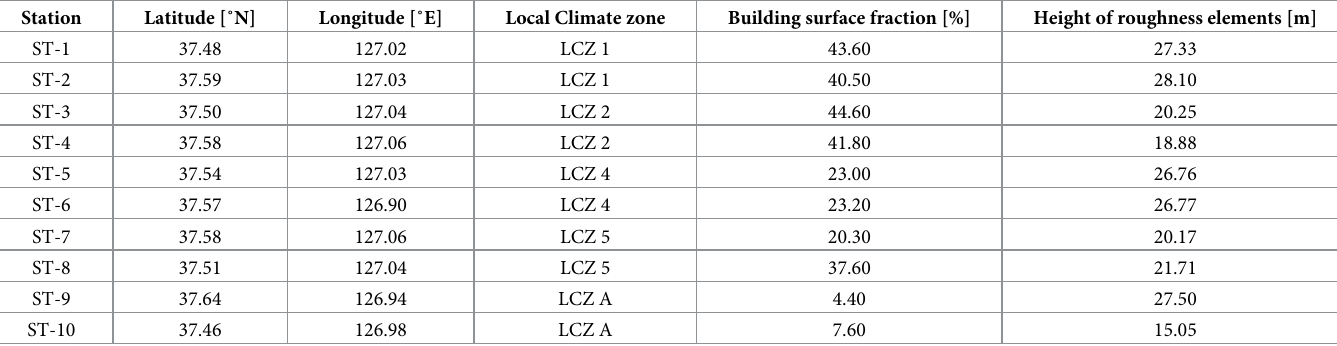
Table 1. Geographical locations of the considered